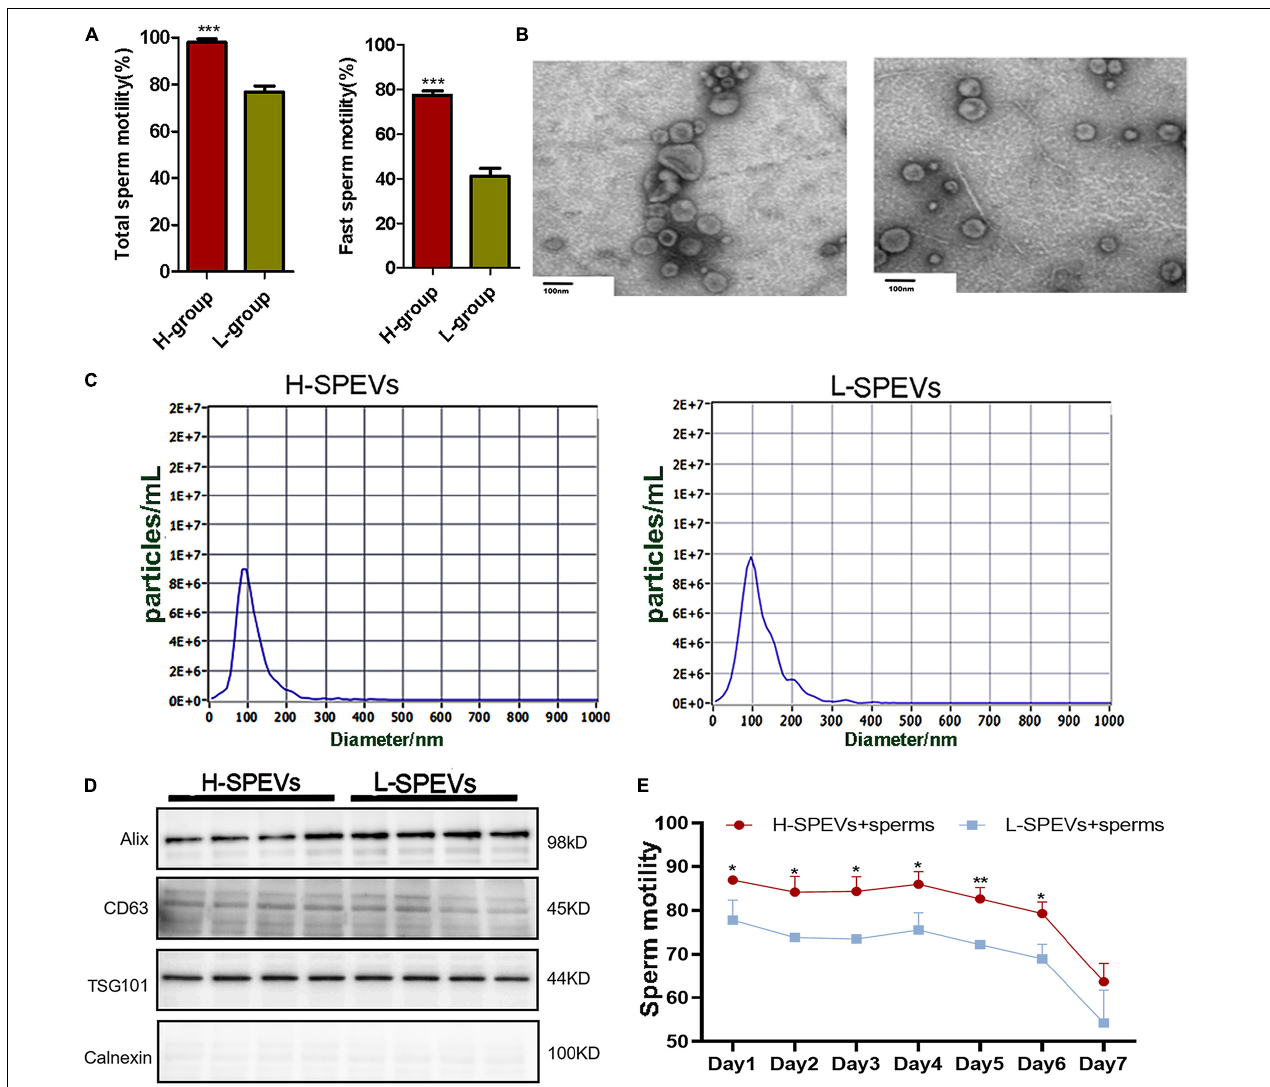
FIGURE 1 | Isolation and characterization of SPEVs from boars. (A) The difference of total sperm motility and fast motility between the two groups. (B) TEM images of SPEVs. Scale bars: 100 nm. (C) NTA results showing that the EVs enriched from seminal plasma were approximately 50–200 nm in diameter. (D) EV markers Alix, Tsg101 and CD63 were all detected in L-SPEVs and H-SPEVs. Calnexin, a negative marker of EVs, was not present in our isolated SPEV samples. (E) Line chart comparing the motility of Duroc boar sperm incubated with H-SPEVs and L-SPEVs. Data are presented as mean ± SEM. (A) *** P ≤ 0.001 (Student’s t -test), n = 4 per group. (E) * P ≤ 0.05, ** P ≤ 0.01, *** P ≤ 0.001 (Student’s t -test), n = 3 per